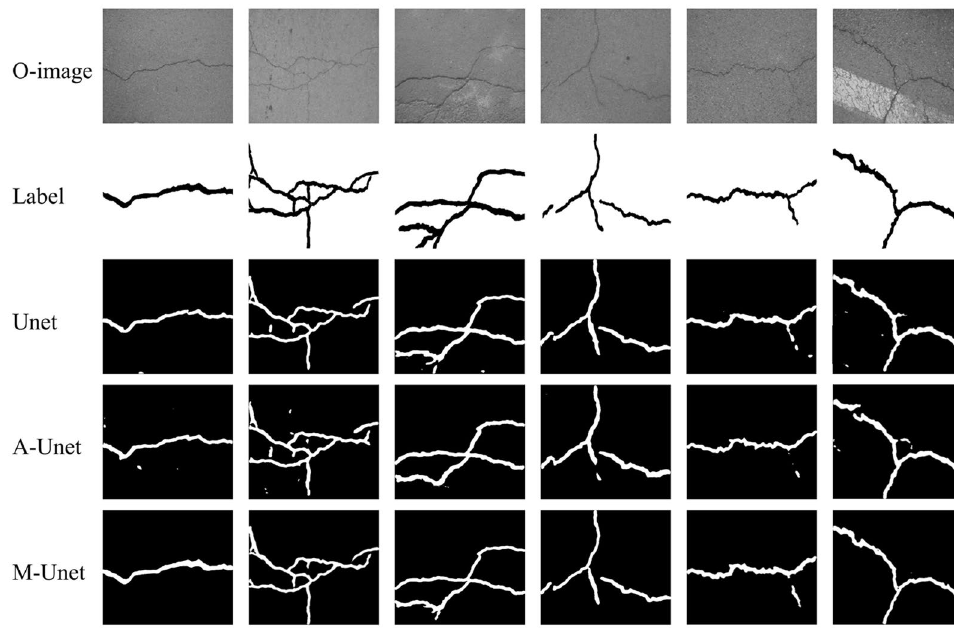
Figure 13 Pitting segmentation results of different neural networks